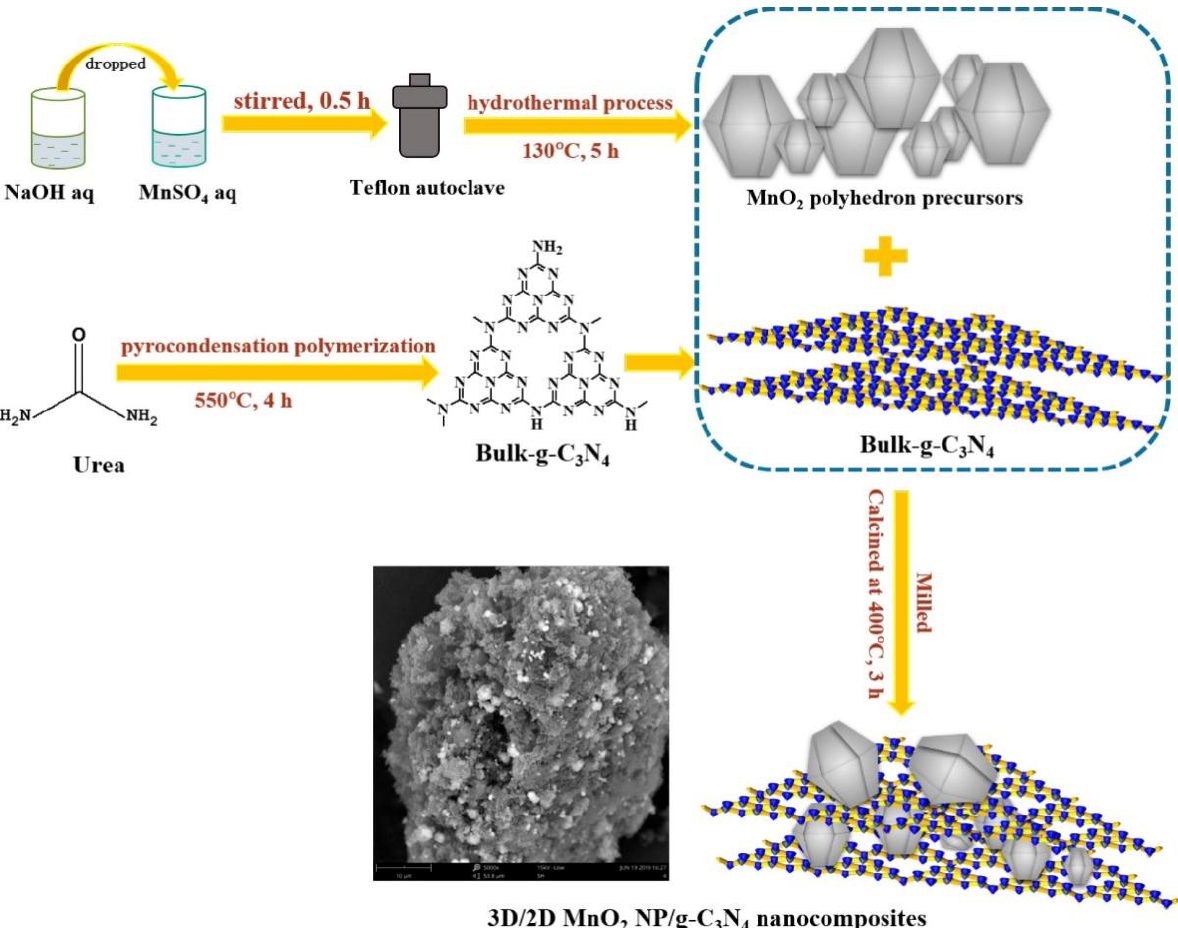
Figure 7. Synthesis procedures of 3D/2D MnO 2 NP/g-C 3 N 4 nanocomposites. Used with permission from [108]. Copyright 2019 American Chemical Society.